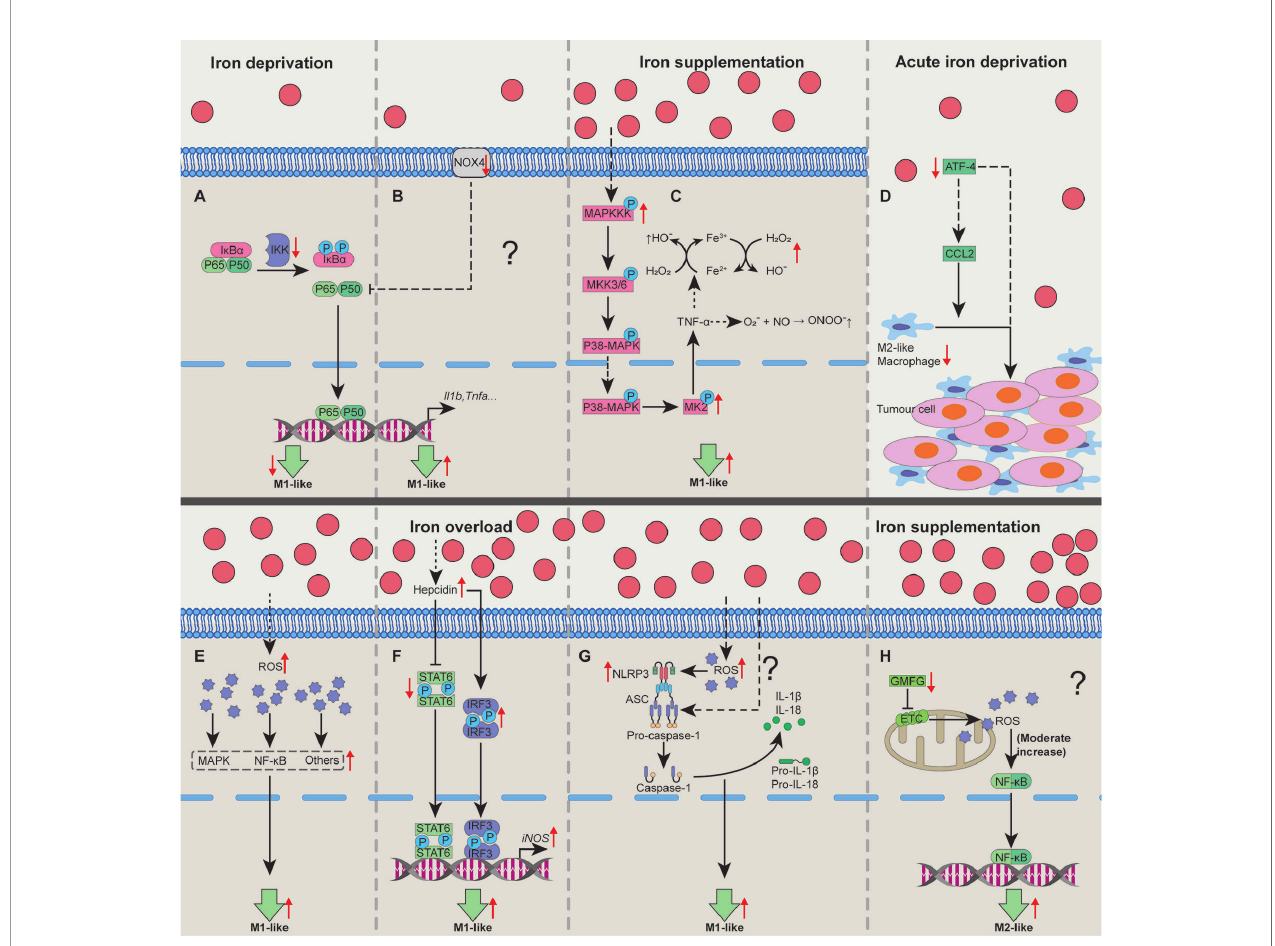
FIGURE 1 | Cellular pathways whereby iron shapes macrophage polarization. Iron deprivation may suppress NF- k B activation to block M1-like macrophage polarization (A) . In some special cases, iron deprivation could lower the activity of Nox to promote p65 nuclear translocation and increases NF- k B activity, promoting M1-like macrophage polarization (B) . Iron treatment could activate MAPK-p-MK2 pathway to increase TNF- a production to generate a large amount of OH • and ONOO • , promoting M1-like macrophage polarization (C) . Acute iron deprivation inhibits ATF4 expression to suppress M2-like macrophage polarization in tumorous tissues (D) . Iron treatment may promote M1-like macrophage polarization by inducing the activation of MAPK, NF- k B and other proin fl ammatory signaling pathways via increasing the production of intracellular ROS (E) . Iron overload increases hepcidin expression which can inhibit STAT6 activation while promote IRF3 expression to increase iNOS expression in M1-like macrophages (F) . Iron can activate NLRP3 in fl ammasome to promote M1-like macrophage polarization by the generation of ROS (G) . Iron might enhance M2-like macrophage polarization through moderately activating of mtROS cascading with NF- k B pathway by down-regulating GMFG level (H) . ATF4, activating transcription factor 4; GMFG, glia maturation factor- g ; IRF3, interferon regulatory factor 3; MAPK, mitogen-activated protein kinase; MK2, kinase 2; NF- k B, nuclear factor k B; NLRP3, NOD ‐ like receptor; Nox, NADPH oxidase; ROS, reactive oxygen species; STAT6, signal transducer and activator of transcription 6. “ ↑ ” , increase; “ ↓ ” , decrease. Question mark means that the mechanism needs experimental con fi